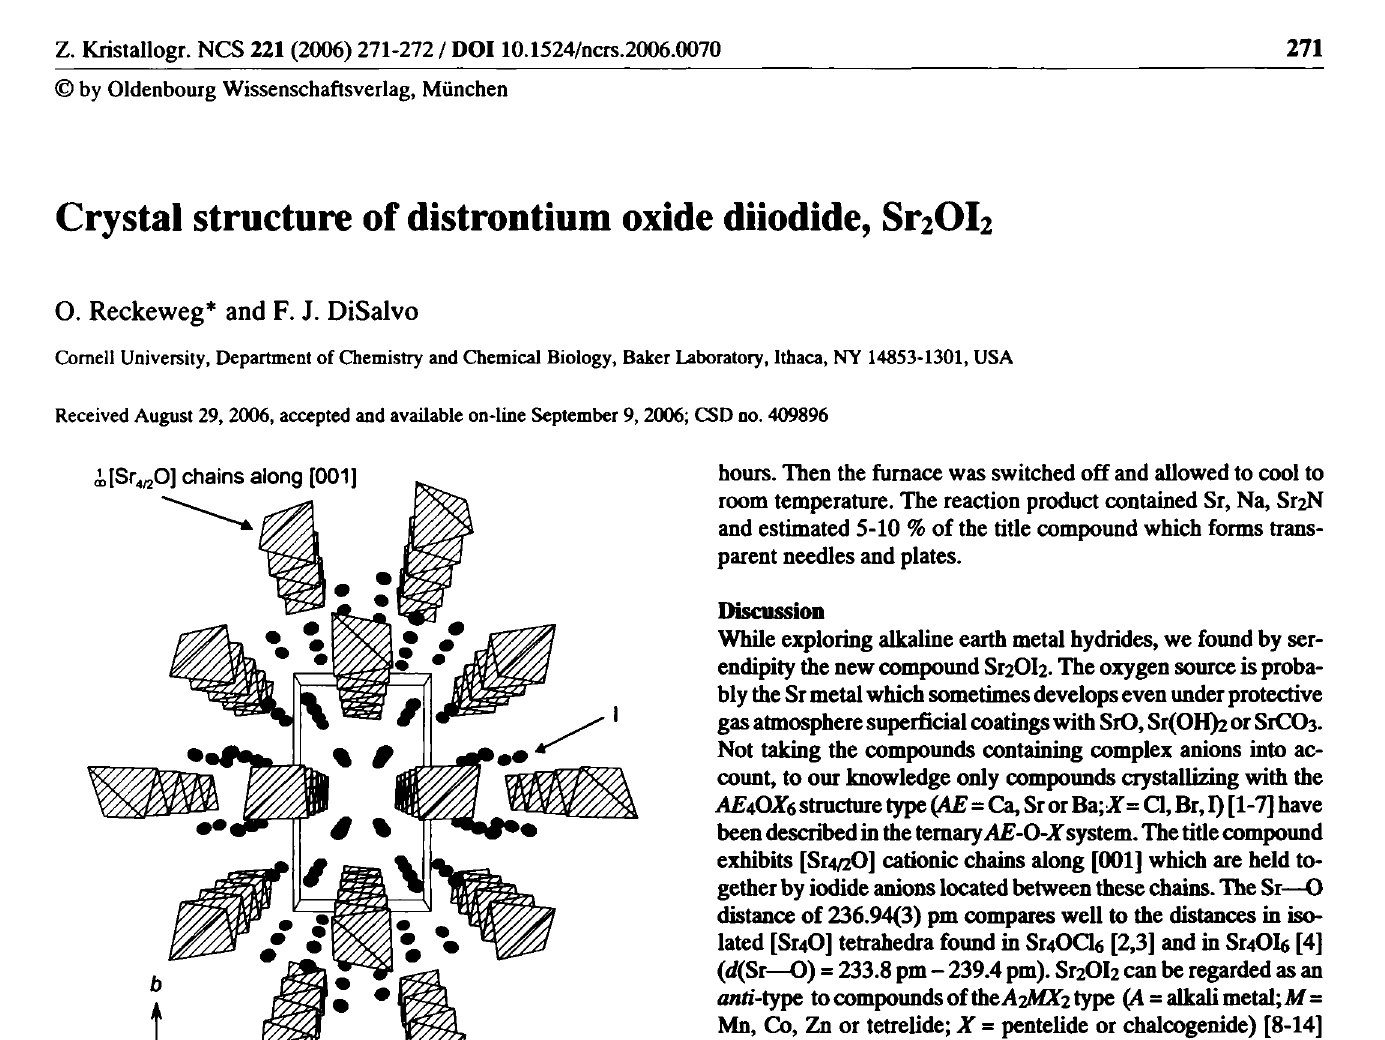
Table 1. Data collection and handling.